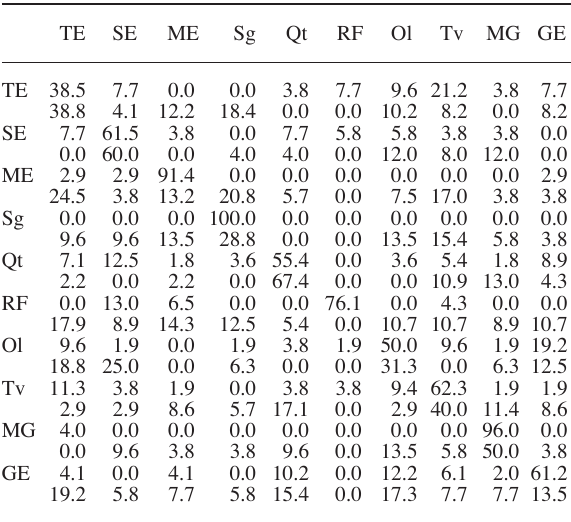
T ABLE 3. – Percentage of individuals of H. didactylus reallocated in each group in the validation of the discriminant analysis for the morphometric and meristic data. Rows are the original sample group and columns the reallocation group. Meristic data are in ital- ics. GE, Guadiana estuary; MG, Monte Gordo; Tv, Tavira; Ol, Olhão; RF, Ria Formosa estuary; Qt, Quarteira; Sg, Sagres; ME, Mira estuary; SE, Sado estuary; TE, Tejo